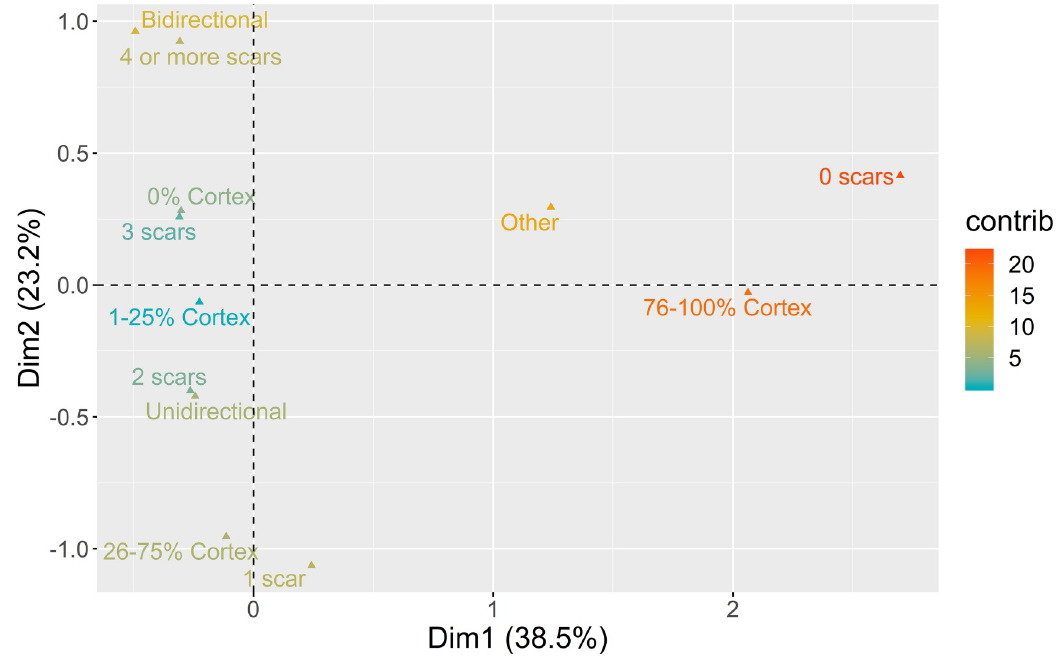
Fig 7. Multiple correspondence analysis plot (first two dimensions) for direction of core exploitation. The color ramp represents the contribution (in %) of the variable categories to the definition of the dimensions.